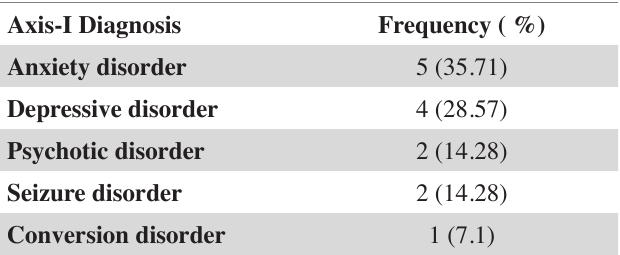
Table 2. Common Axis I diagnosis